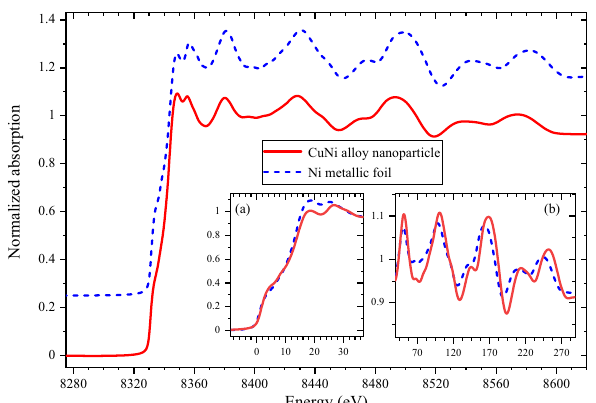
Figure 2. Normalized X-ray absorption fine structure (XANES) spectra at Ni K-edge of the sample (red curve) and metallic Ni foil (blue curve). Insets ( a ) and ( b ) respectively show zoomed areas over the edge and the near- edge features without any vertical shift unlike in the main panel where the two spectra are shifted vertically for clarity in presentation. For the insets, the absorption edge energy is set to